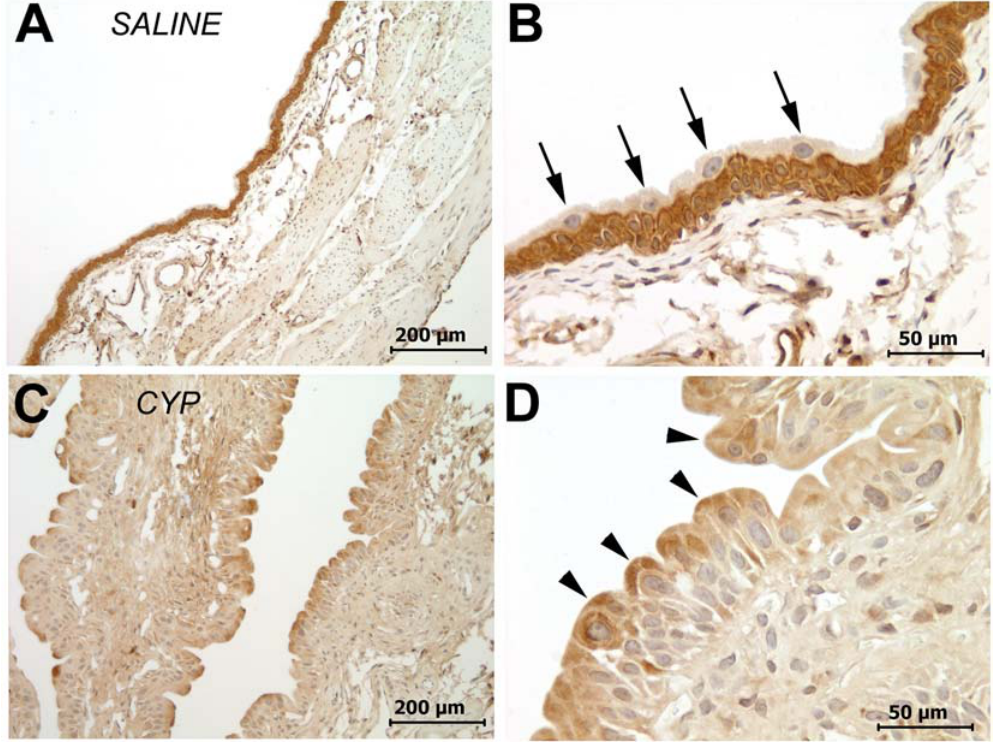
Figure 2. Representative CXCR4 immunostaining in urothelium of saline-treated (A;B) and CYP-treated (C,D) rats. Moderate to strong CXCR4 immunostaining was seen in basal and intermediate cells in the urothelium of saline treated rats (A;B), with little or no staining in superficial cells (B; arrows). In CYP-treated rats, there is a significant redistribution of CXCR4 immunostaining with decreased basal and intermediate cell staining (C;D) while superficial cells appeared stained and moderate staining in apical areas (D; arrowheads). Calibration bar: 2A,2C=200 m m; 2B;2D=50 m